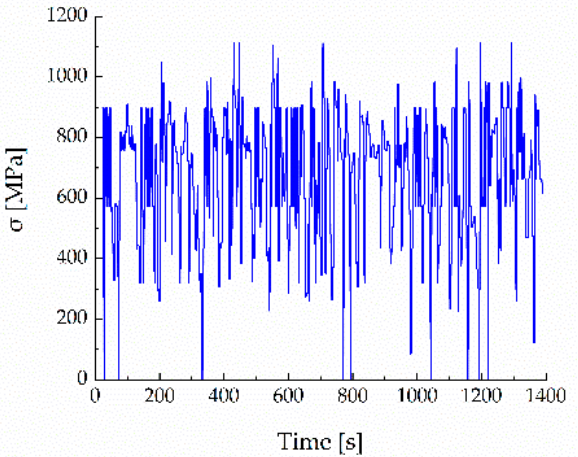
Figure 11. Contact stress load spectrum of friction braking.